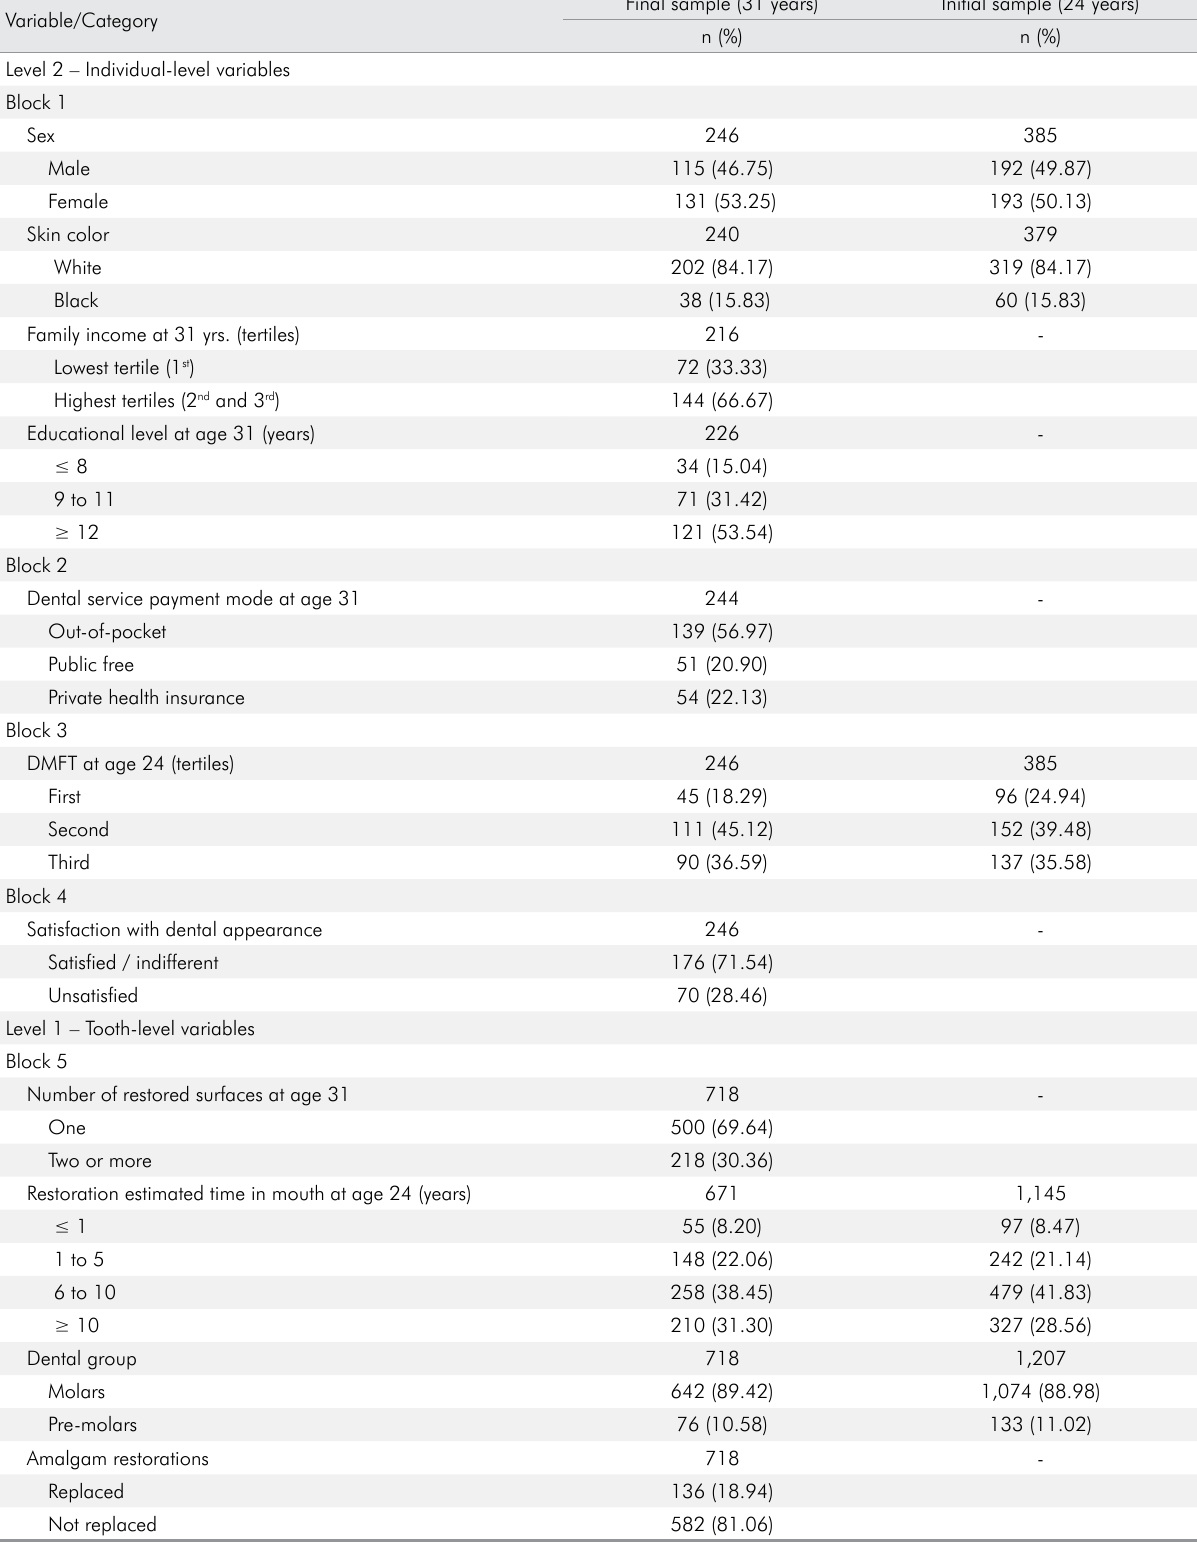
Table 1. Amalgam restorations in posterior teeth by socio-economic, oral health, and dental service utilization variables in a sample of young adults. Pelotas, RS, Brazil. (n =